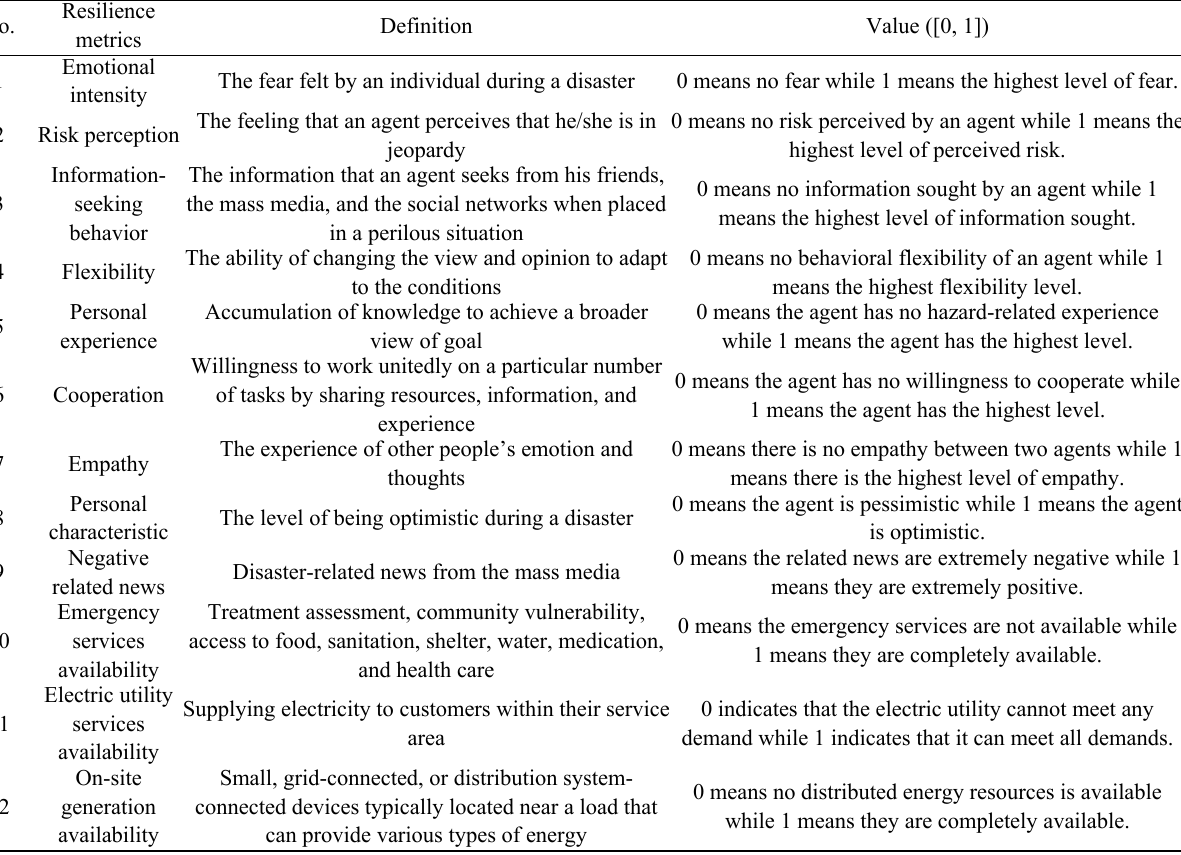
Table 1 Definition of the resilience metrics and the meaning of their numerical values. The social features for community features are assumed to follow a Gaussian distribution with a mean over the interval [0, 1].